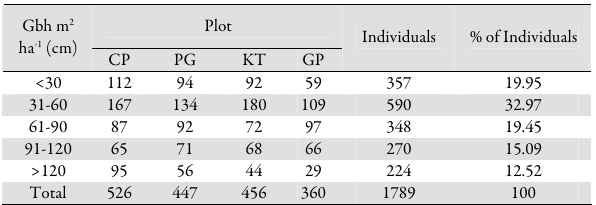
Tab. 2. Girth class-wise population density of tree species ( ≥ 15 cm gbh) in four 1-ha plots